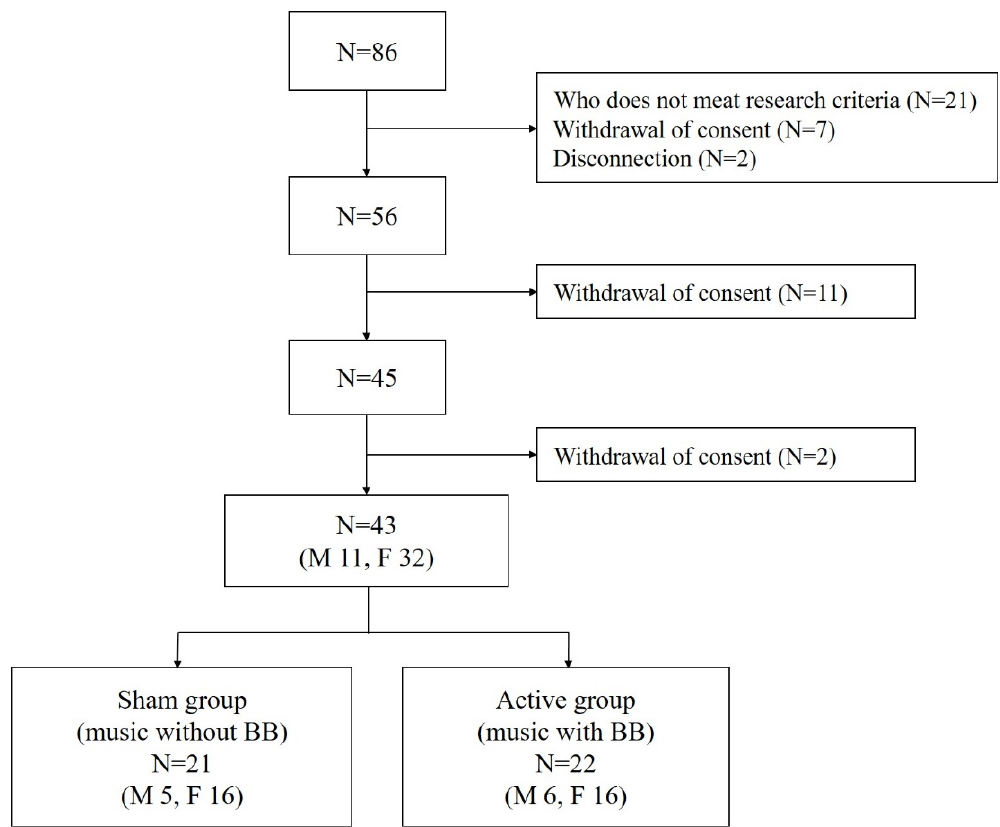
Figure 1. Flow chart summary of the participants. N indicates number; M, male; F, female.